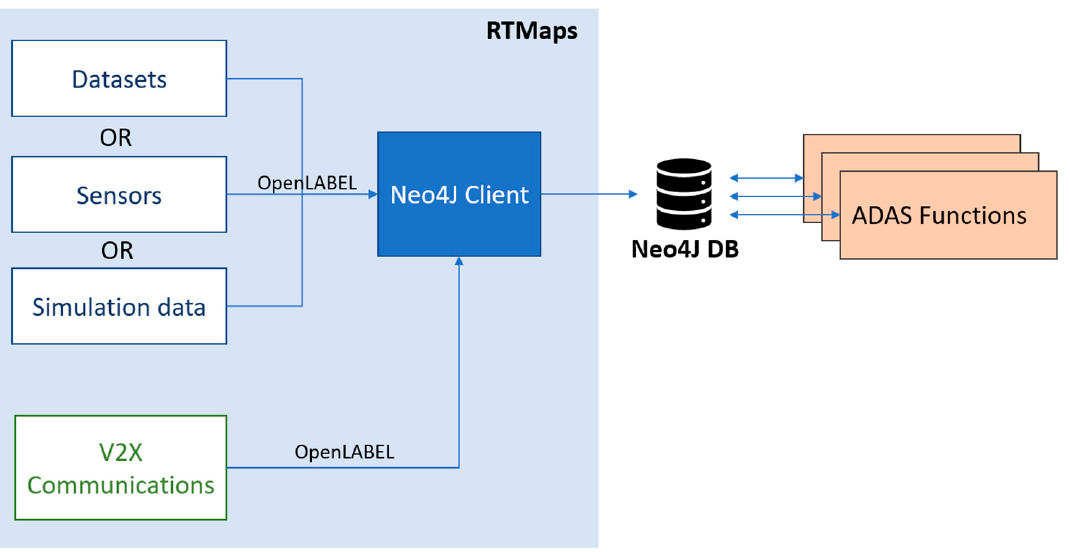
Figure 9. Dynamic data feeding process to the iLDM from RTMaps.